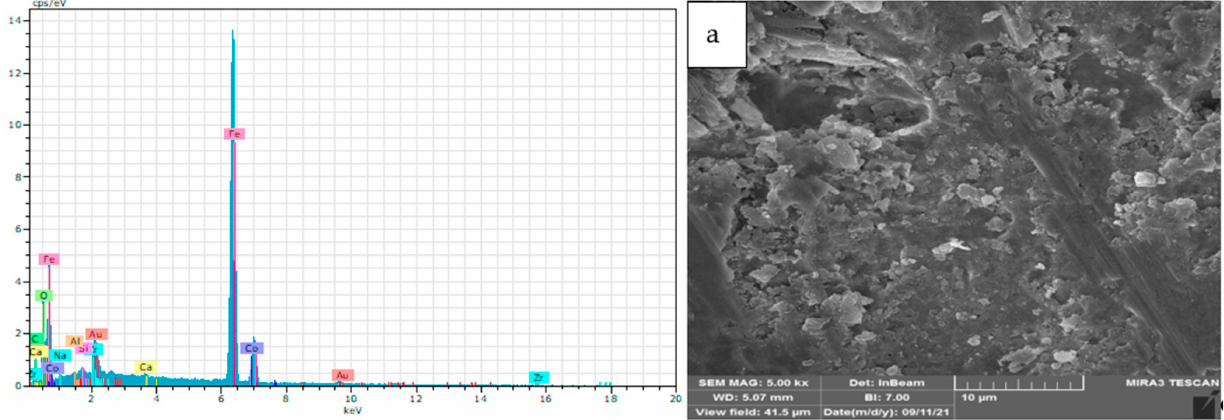
Figure 12. SEM images of iron surface before ( a ) and after EC ( b ). 4. Energy Consumption and Metal Loading Energy consumption is a parameter that directly affects operating costs. This pa- rameter depends on several factors that are calculated via the following Equations. E = EC + E photo (34) EC= (cid:2905)×(cid:2893)×(cid:2930) (cid:2869)(cid:2868)(cid:2868)(cid:2868)×(cid:2906) (35) E photo = ELED + E UV (36) where U represents the voltage applied, I represent the electric current, t is the time (h), and V is the treated effluent volume (m 3 ). Moreover, the amount of energy consumed in the photo system is calculated using the following Equation: E photo= (cid:2900)(cid:2915)×(cid:2930)×(cid:2869)(cid:2868)(cid:2868)(cid:2868) (cid:2906)×(cid:2874)(cid:2868)×(cid:2922)(cid:2925)(cid:2917) ( (cid:3135)(cid:3167) (cid:3135)(cid:3164) ) (37) where Pe represents the electrical power (kW), t is the time (min), V is the treated effluent volume (m 3 ), Ci is the initial pollutant concentration, and Cf is the final pollutant con-